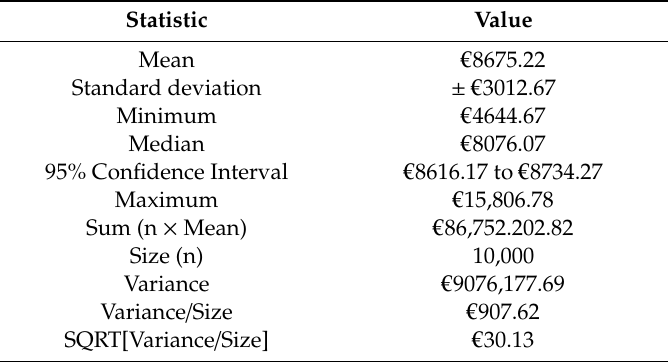
Table 3. Weighted mean of outpatient costs